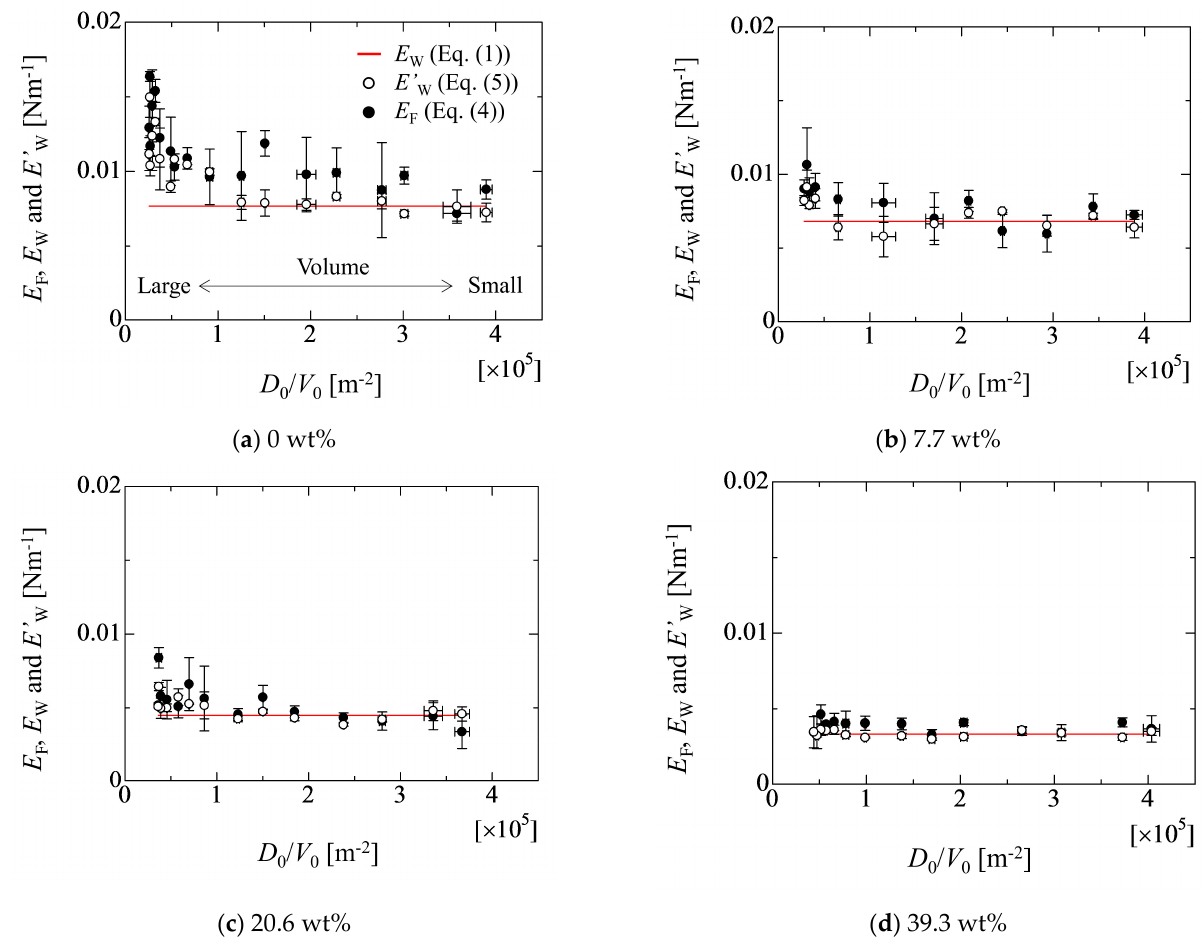
Figure 9. Relationship between adhesion force and D 0 / V 0 in each liquid property.